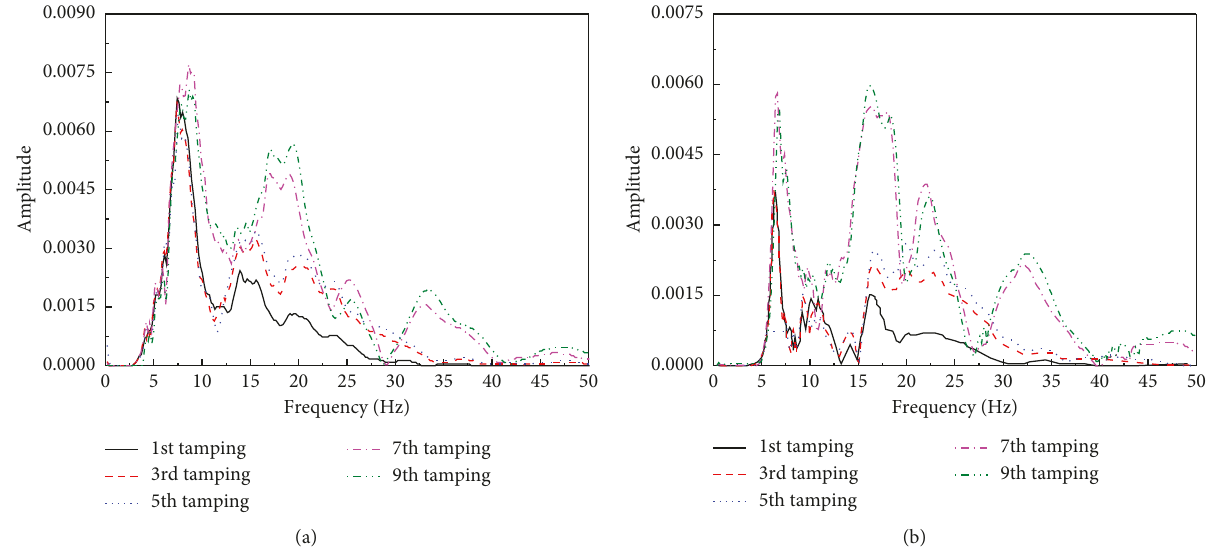
Figure 10: Fourier amplitude spectrum in radial and vertical directions at 80m distance. (a) In radial direction. (b) In vertical direction.